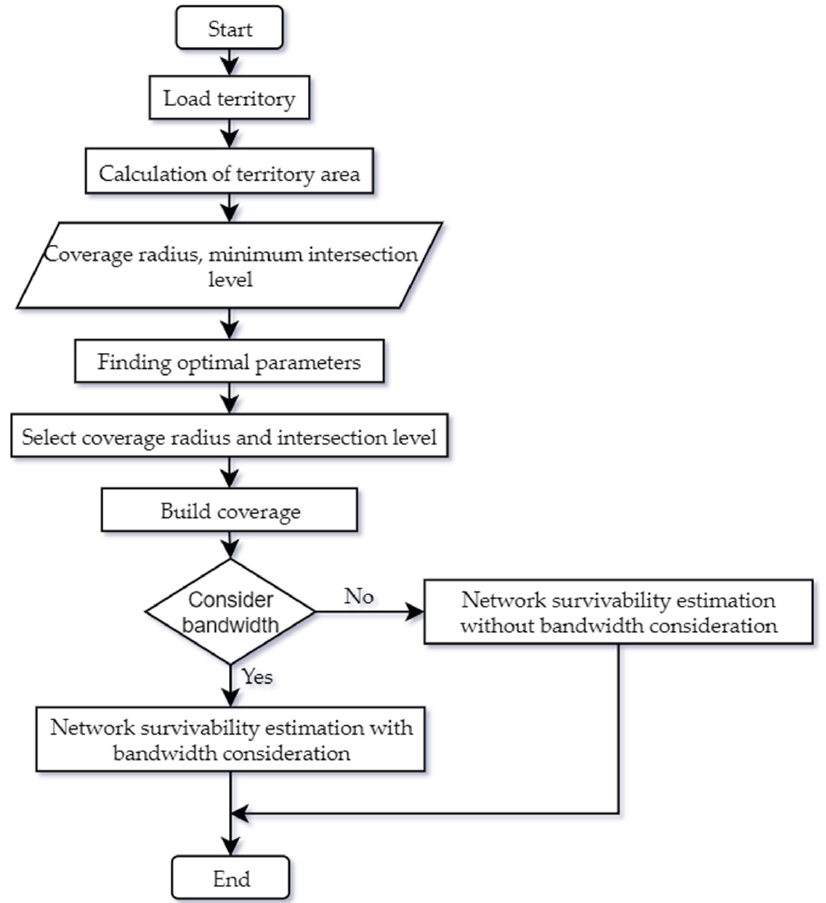
Figure 5. Maximum coverage of the territory by sensors with minimization of cost and assessment of survivability method flow chart.